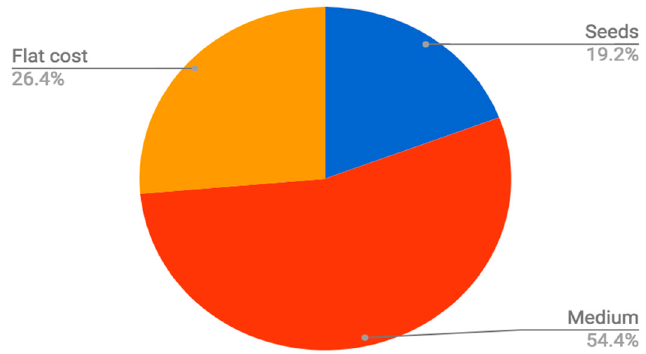
Figure 1. Flat material input costs.